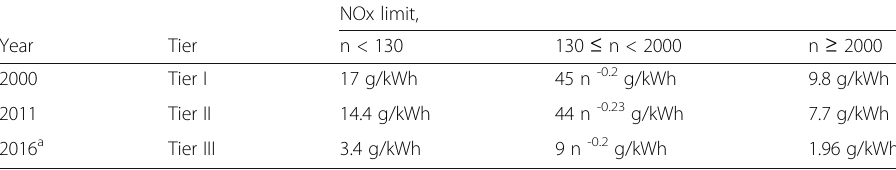
Table 2 MARPOL Annex VI NO x emission